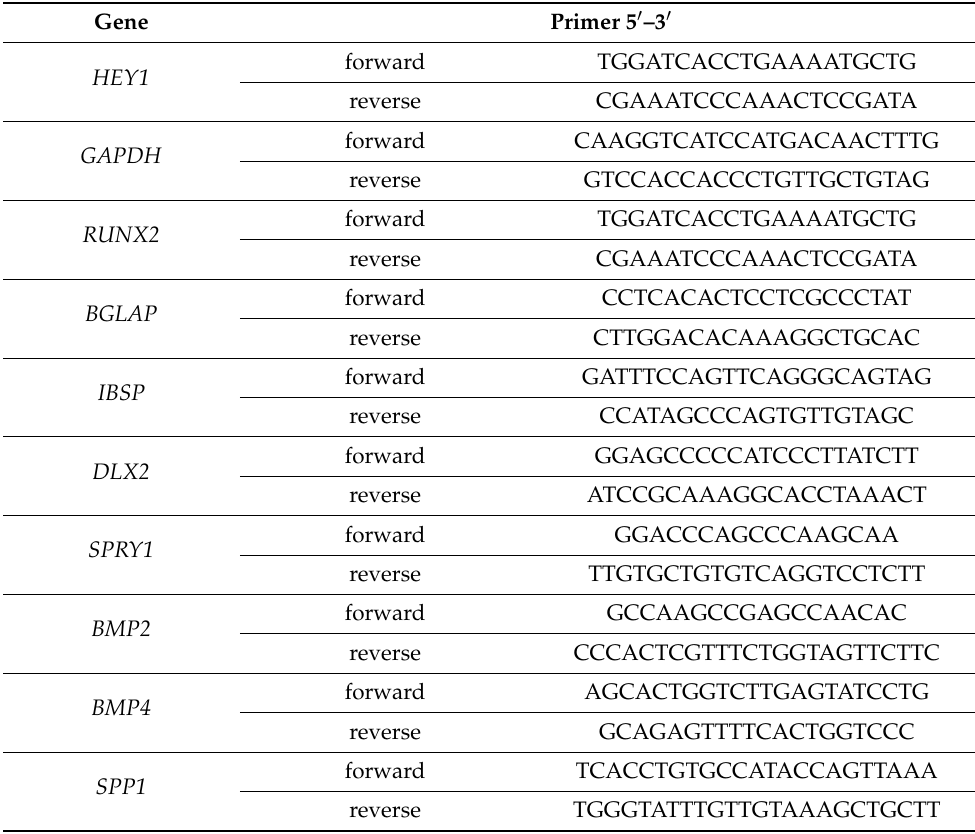
Table 1. Primers for the human genes used in the study.